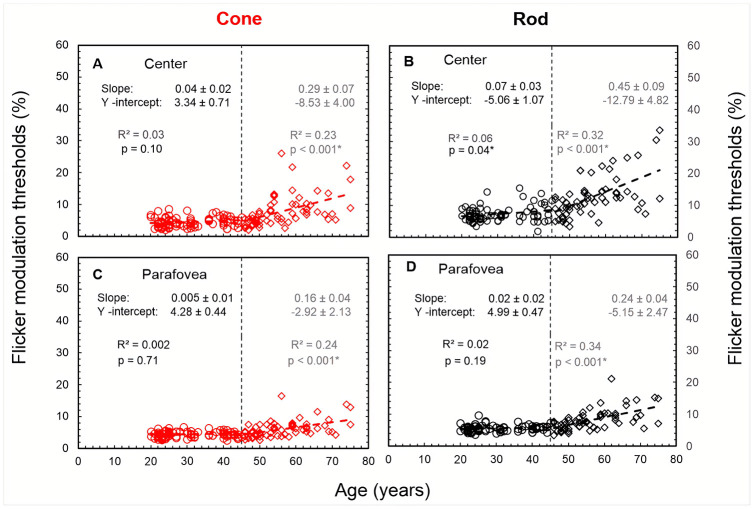
Cone (left panels) and rod (right panels) FMT as a function of age for central and parafoveal locations.Linear regression analysis based on least squares method was performed separately on both segments (≤ 45 years and > 45 years) to obtain the best fit. The dotted, vertical lines indicate the chosen cut-off age, which is 45 years. The slopes (± SE, standard error) and the y-intercept (SE) is denoted separately for both age groups in each of the panels. The variance of FMTs that can be expressed by variation in age is indicated by the R2 values, adjusted for the sample size. The asterisk symbol in the equations indicated if the slope was significantly different from zero.